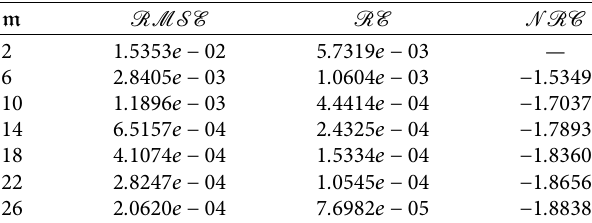
Table 3: RMSE , RE , and NRC for diferent m for Example 3.